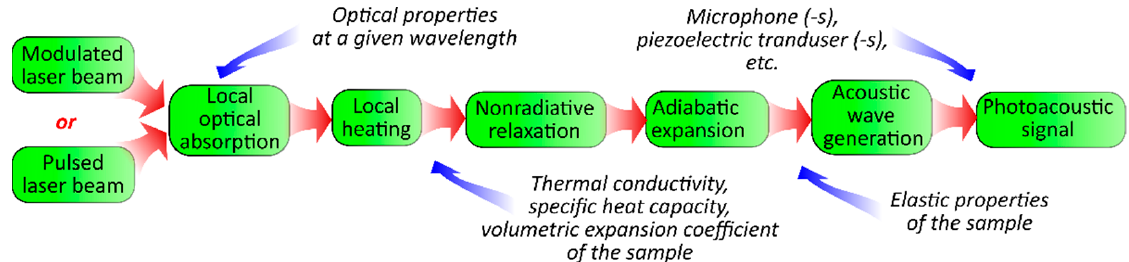
Figure 1. Physical processes involved in PA signal formation.